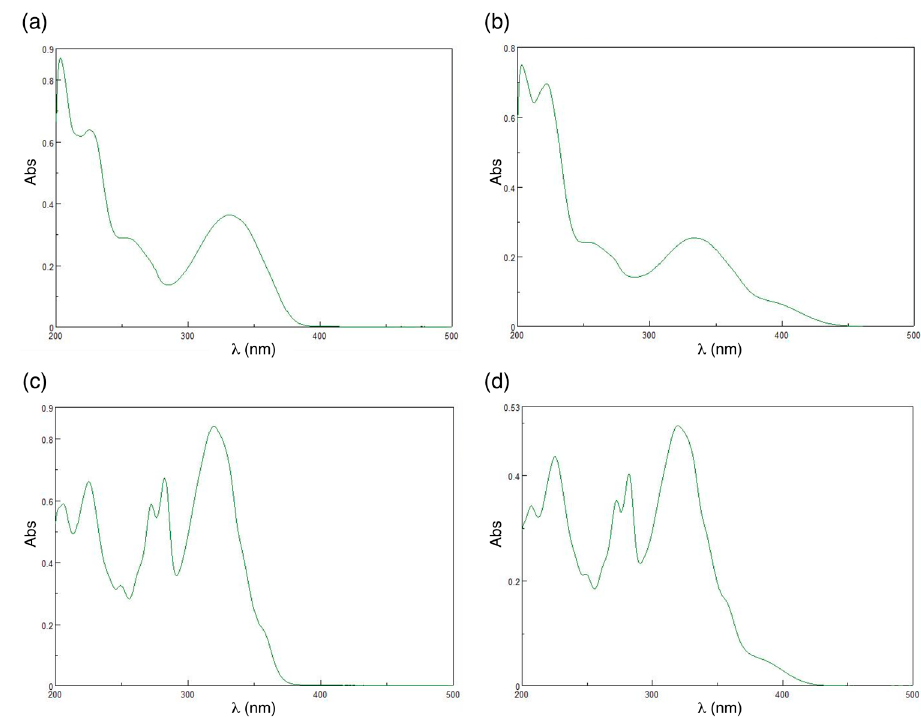
Figure 3. UV-vis spectra in EtOH for ( a ) 1a (2.09 × 10 − 5 mol/L); ( b ) 1a · HCl (1.80 × 10 − 5 mol/L); ( c ) 1b (2.34 × 10 − 5 mol/L); and ( d ) 1b · HCl (1.82 × 10 − 5 mol/L).